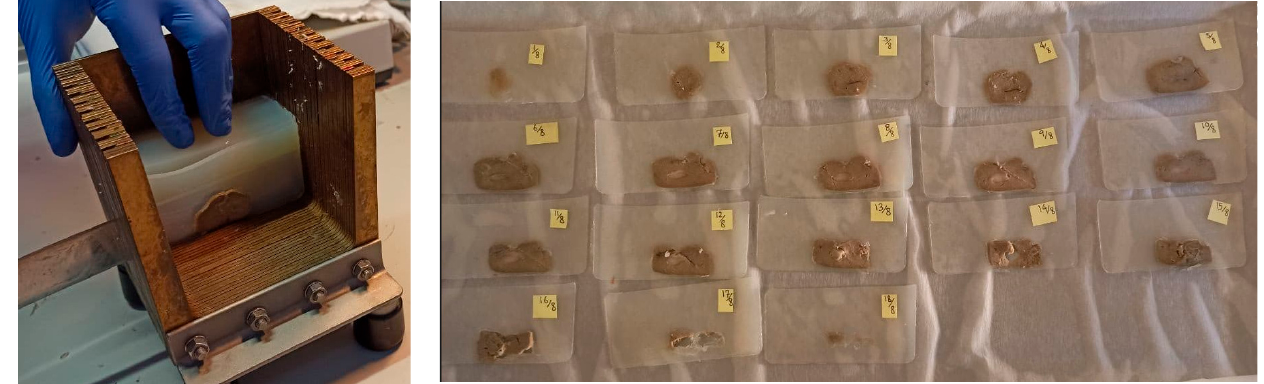
Figure 2. Slicing of the specimen using a specific device that allows for thin and parallel cutting.